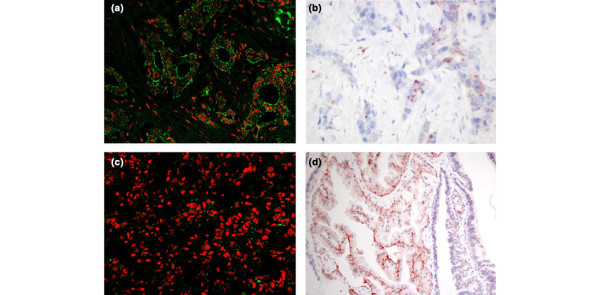
Claudin (CLDN)1 positivity in normal breast epithelium, tumour cell membranes and intraductal papilloma. (a) CLDN1 positivity in normal breast epithelium. Normal epithelial cells exhibit intensive CLDN1 positivity in the cell membrane. Image obtained using laser scanning confocal microscopy (MRC 1024; Bio-Rad). Primary antibody was CLDN1 polyclonal antibody (Zymed); secondary antibody was IgG conjugated to Alexafluor 488 (Molecular Probes). Cell nuclei were counter-stained with propidium iodide. Green fluorescence along the cell membranes corresponds to CLDN1; the nuclei are seen in red. (Original magnification: 400×.) (b) CLDN1 positivity in tumour cell membranes. Shown is the immunohistochemical reaction of invasive ductal carcinoma of the breast using polyclonal CLDN-1 antibody. Note the membrane staining only in some scattered tumour cells, as compared with normal epithelial cells (panel a). Sections were counter-stained with Mayer's haemalaun. The chromogen substrate was aminoethylcarbazol. (Original magnification: 600×.) (c) CLDN1 positivity in tumour cell membranes. Shown is the immunohistochemical reaction of invasive ductal carcinoma using polyclonal CLDN1 antibody. There is scattered membrane staining in some tumour cells. The secondary antibody is IgG conjugated to Alexafluor 488. Cell nuclei were counter-stained with propidium iodide. The image was obtained using laser scanning confocal microscopy (MRC 1024; Bio-Rad). (Original magnification: 400×.) (d) CLDN1 positivity in intraductal papilloma. Shown is the immunohistochemical reaction of a breast papilloma with an area of apocrine metaplasia. There is increased CLDN1 positivity in apocrine cells and negative staining in the surrounding papilloma. Sections were counter-stained with Mayer's hemalaun. The chromogen substrate was aminoethylcarbazol. (Original magnification: 200×.)